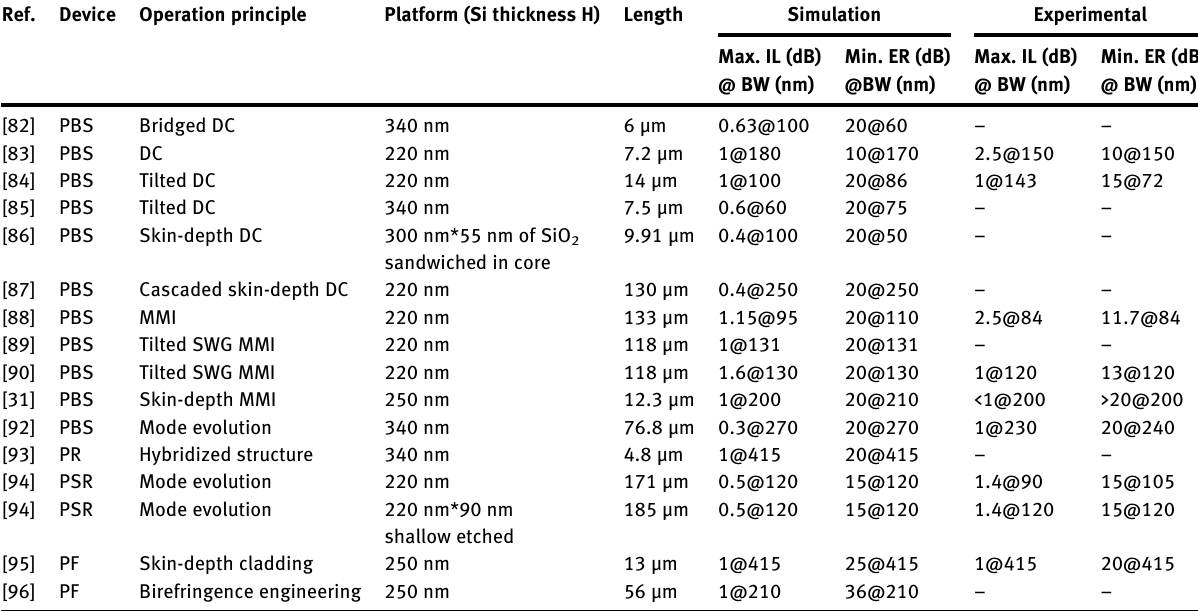
Table  : Performance comparison of recently demonstrated subwavelength-enhanced polarization beam splitters. Ref. Device Operation